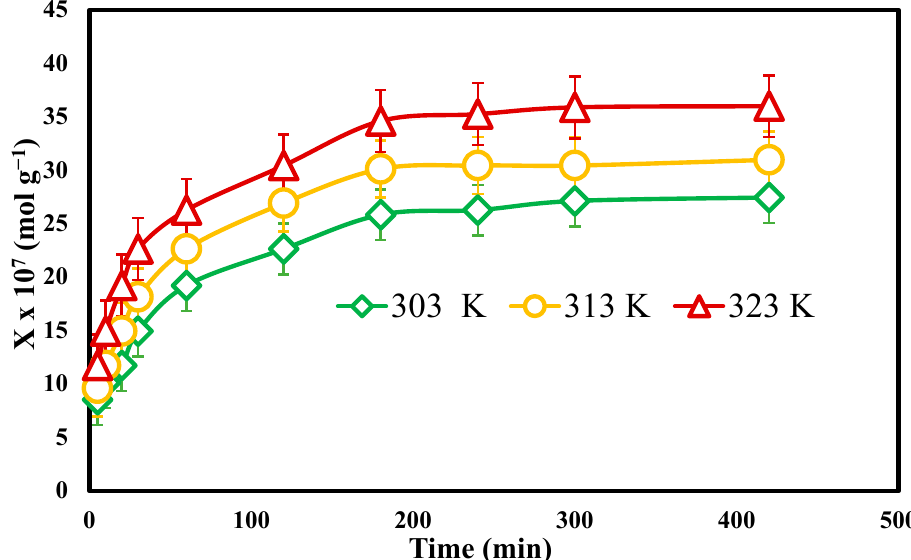
Figure 5. Point of zero charge of MgO-IBC composite.